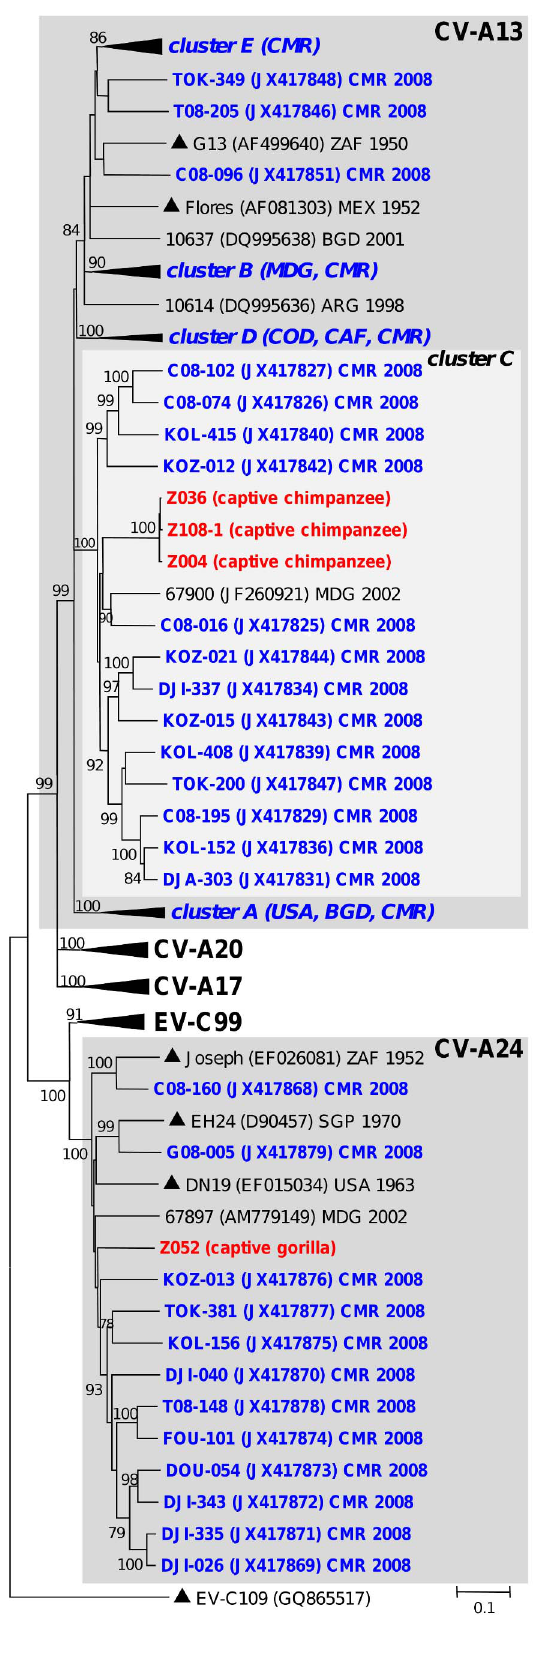
Figure 2. Phylogenetic relationships among Enterovirus C strains from human and non-human primates. The NJ tree is based on the alignment of the full-length VP1 sequences. Studied viruses from apes are highlighted in bold red with host names indicated in brackets while human-derived isolates from Cameroon are specified in bold blue. Prototype strains are indicated by triangles ( m ). For clarity, type and lineage-specific clusters containing exclusively human isolates have been collapsed. The scale is shown at the bottom as substitutions per site. Viral isolates belonging to enterovirus species commented in the text are gathered in grey-shaded